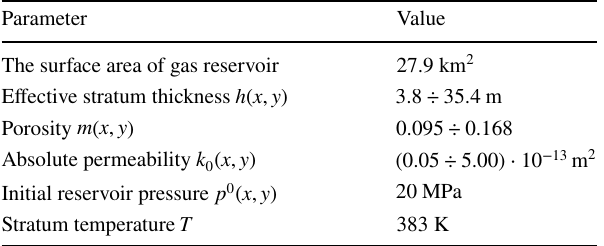
Table 1 Source data for the Kotelevske gas reservoir